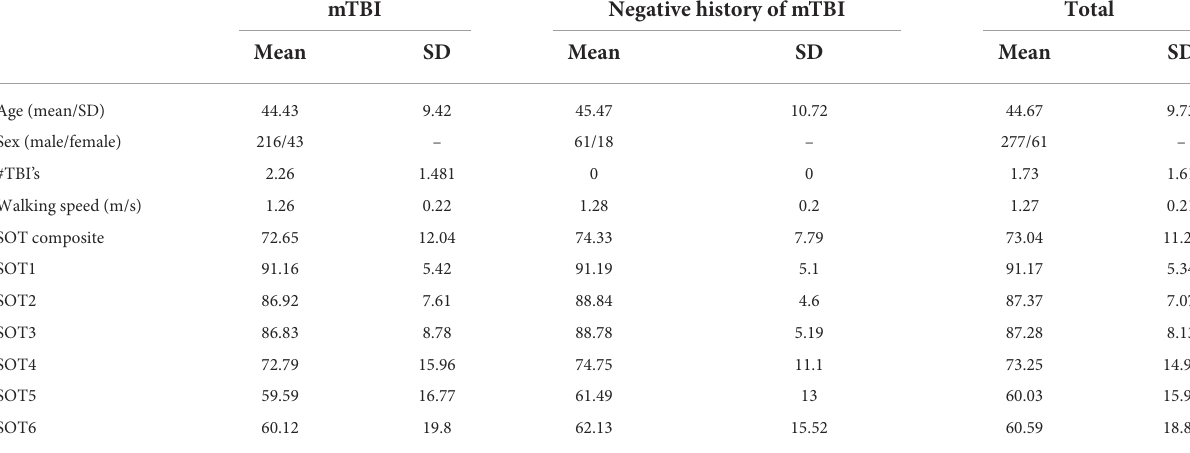
TABLE 1 Participant demographics, mean ± standard deviation, except for gender (male/female). mTBI Negative history of